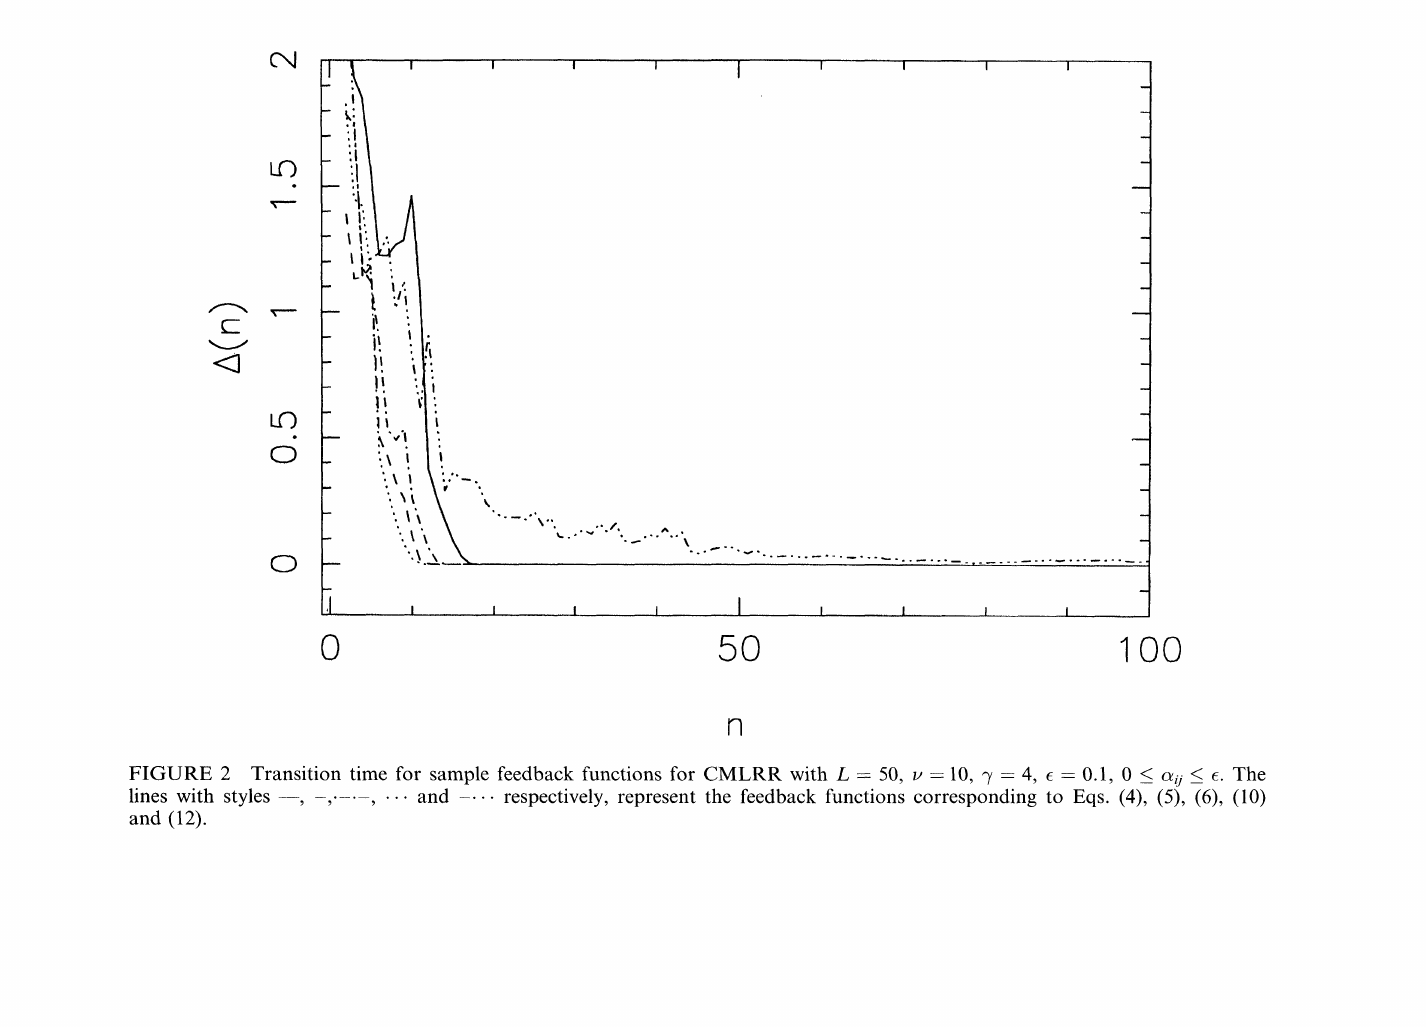
FIGURE 2 Transition time for sample feedback functions for CMLRR with L